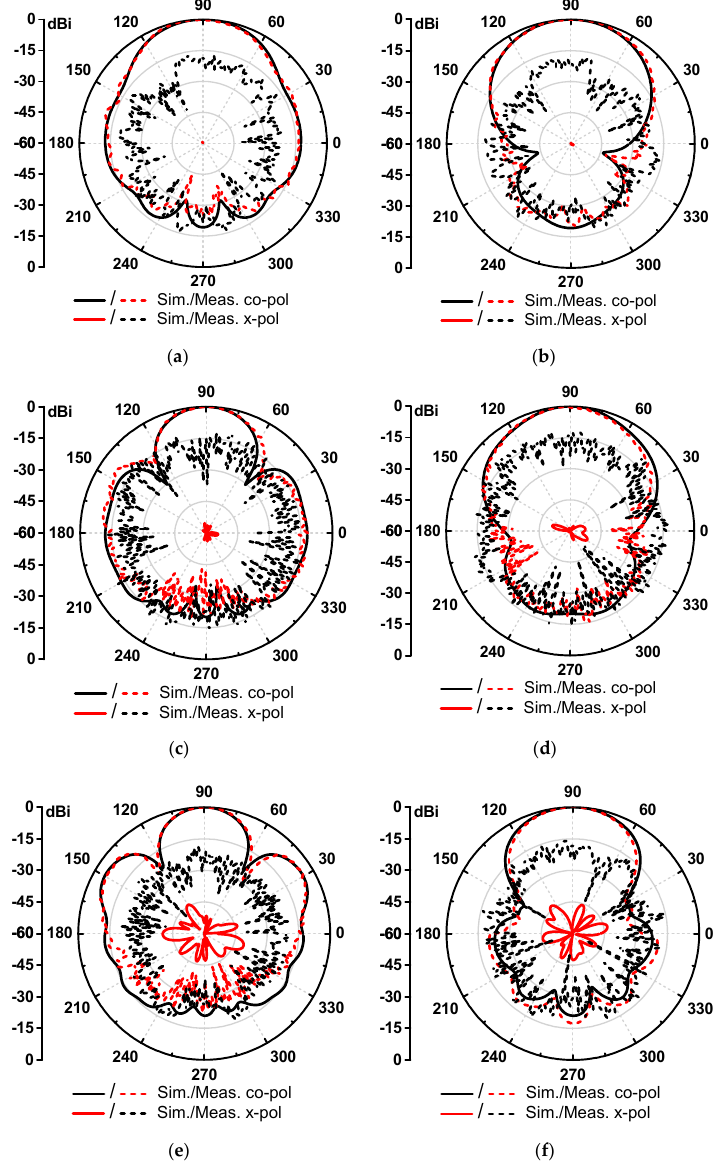
Figure 12. Simulated and measured radiation patterns of the proposed SWA: ( a ) E -plane at 11.0 GHz; ( b ) H -plane at 11.0 GHz; ( c ) E -plane at 16.15 GHz; ( d ) H -plane at 16.15 GHz; ( e ) E -plane at 20.0 GHz; ( f ) H -plane at 20.0 GHz.